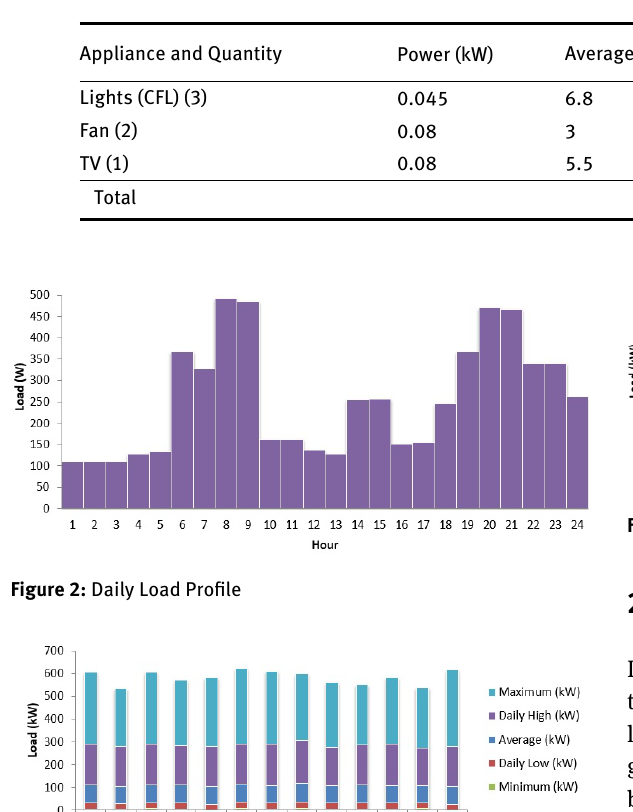
Table 2: Average Electric load Demand of a typical household